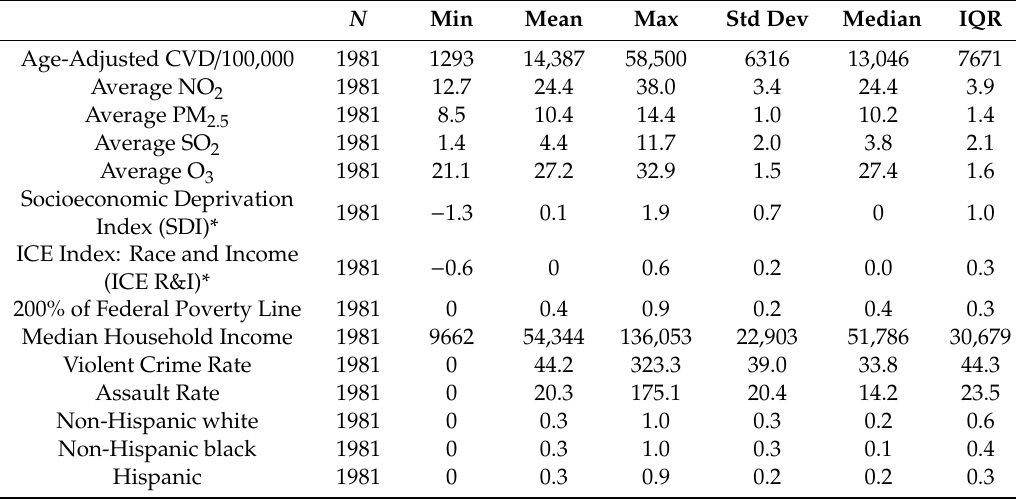
Table 1. Summary statistics by census